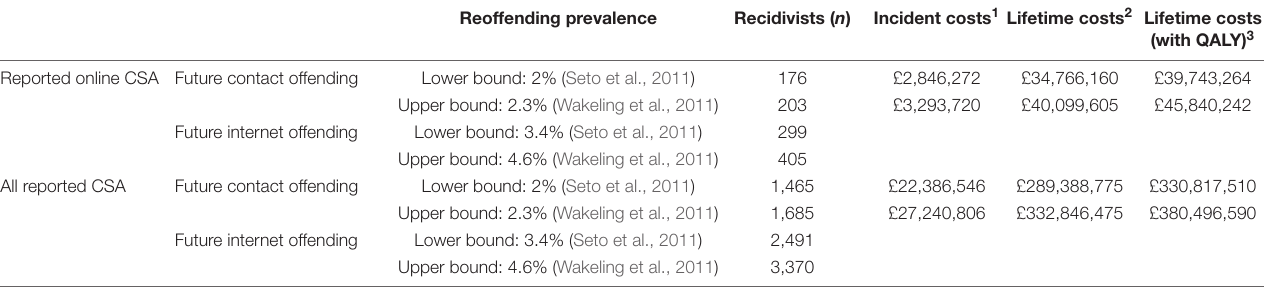
TABLE 12 | Reductions in recidivism – estimated at one victim per